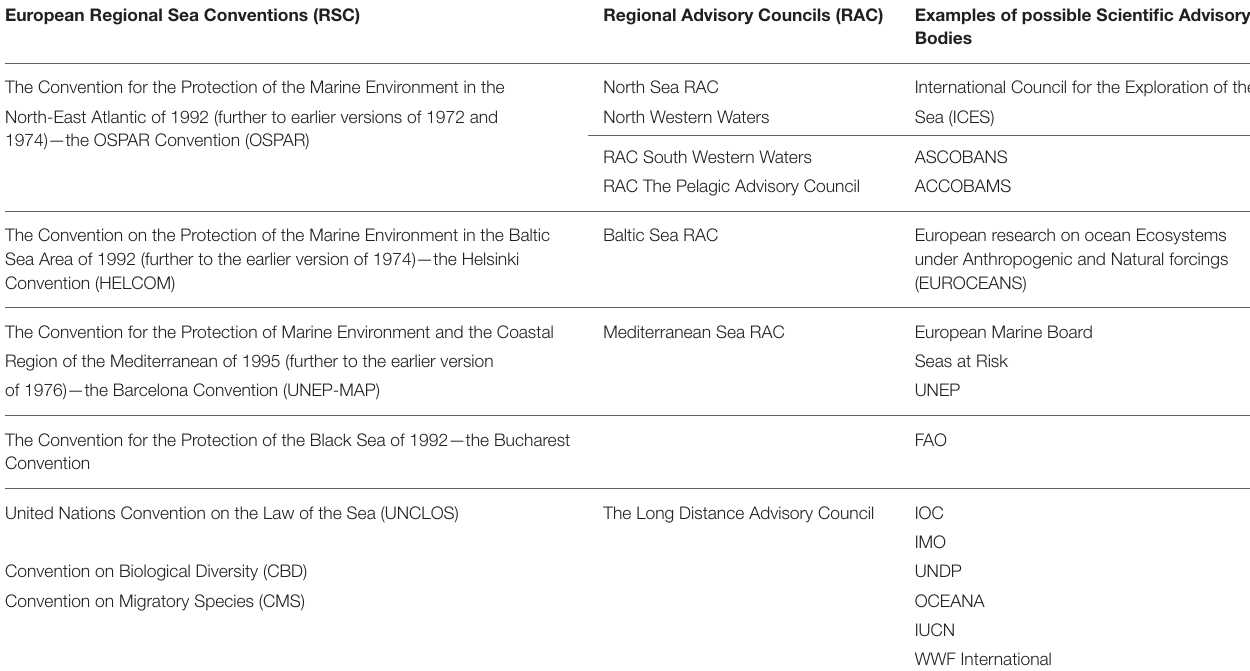
TABLE 1 | Interested parties referred to in the Marine Strategy Framework